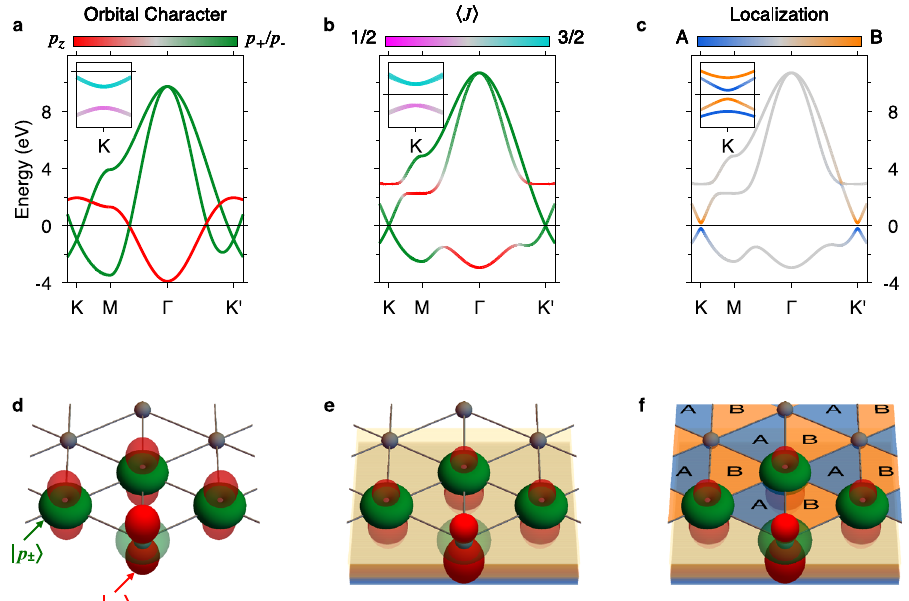
Fig. 2 Model for a triangular QSHI on a substrate. a – c Band structures without (with) SOC in the main panels (insets) and corresponding models d – f for a { p + , p − , p z } basis on a triangular lattice. a , d The orthogonality of the p z and the in-plane orbitals promotes a metallic band structure with Dirac states at K / K ′ which split in the presence of SOC into states with strong J ¼ 1 and 3 character in valence and conduction band, respectively. b , e The presence of a 2 2 substrate allows for p z and p ± orbital-mixing and opens a hybridization gap. With SOC, a topologically non-trivial insulating ground state is realized (inset to b ). c , f in case of broken inversion symmetry, the blue (A) and orange (B) triangles become inequivalent. Without SOC the system is in the trivial phase and the whole valence (conduction) band localizes in the A- (B-)triangle. The inset to c shows the SOC-dominated non-trivial band ordering with spin-split p ± states at the valley momenta. The valence (conduction) bands localize now on both triangles of the A/B sublattice. This distinctive A/B localization motif is the same at K and K ′